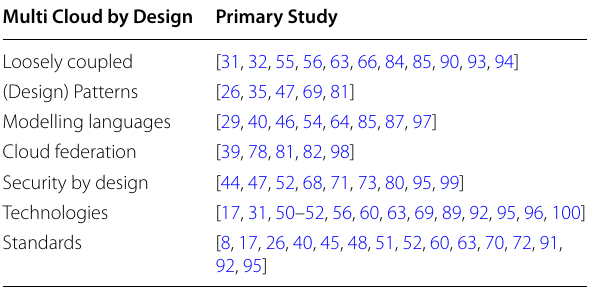
Table 7 Multi‑cloud by design topics addressed by the primary